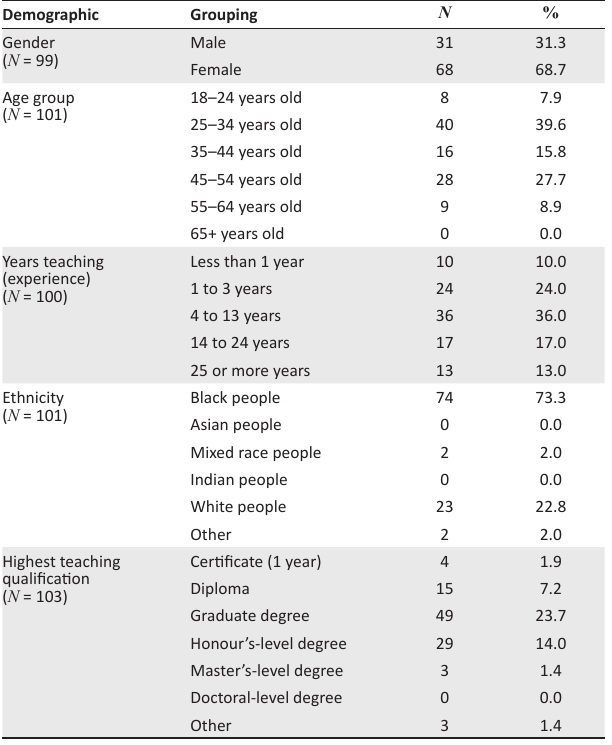
TABLE 2: Characteristics of participants ( N = 144).